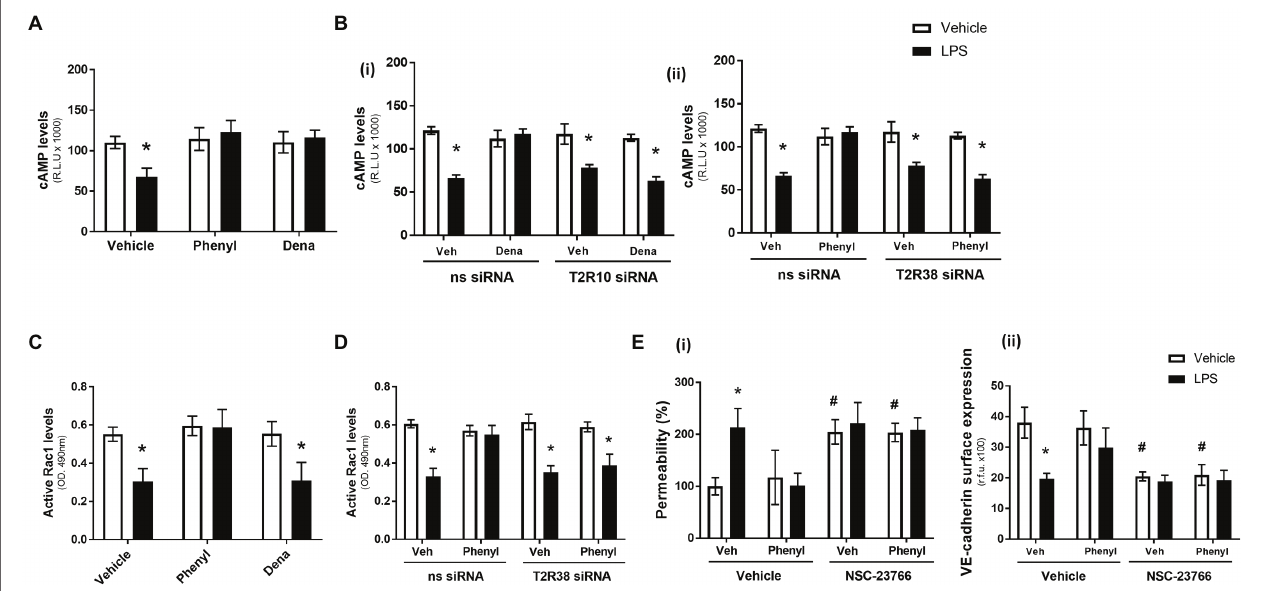
FIGURE 2 | Phenylthiourea (Phenyl), but not denatonium (dena), acts through a cAMP-Rac1-dependent signalling pathway to protect the pulmonary endothelial barrier. Panel A and C : HPAEC were exposed to noscapine, denatonium or phenylthiourea (0.1 mm) in the presence (closed bars) or absence (open bars) of LPS (1 μ g/ml) for 24 h. cAMP (panel A ) and Rac1 (panel C ) levels were measured using commercially available ELISA kits. Panel B and D : T2R10 [panel B (i)]- or T2R38 [panel B (ii)]-specific siRNA was used to knockdown expression in HPAEC and denatonium or phenylthiourea (0.1 mm), respectively, was added after 24 h in the presence (closed bars) or absence (open bars) of LPS (1 μ g/ml). cAMP (panel B ) and Rac1 (panel D ) levels were measured using commercially available ELISA kits. Panel E : HPAEC were exposed to the Rac1 inhibitor, NSC-23766, with phenylthiourea (0.1 mm) in the presence (closed bars) or absence (open bars) of LPS (1 μ g/ ml) for 24 h. Monolayer permeability was measured using the FITC-dextran essay [panel E (i)] and VE-cadherin surface expression was assessed using whole cell ELISA [panel E (ii)]. Data are presented as mean ± S.D. n = 5, 6. Panel * p < 0.05 versus vehicle for LPS; # p < 0.05 versus vehicle for